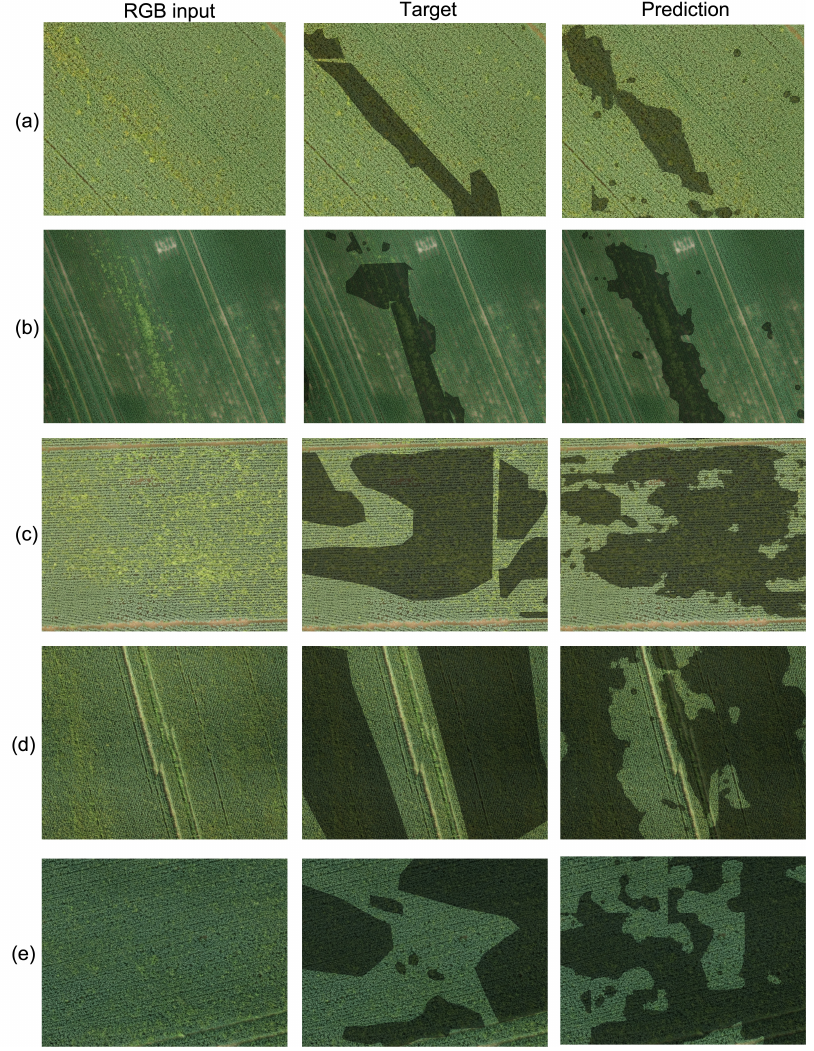
Figure 2. Examples of model predictions for five fields. 1st column: original RGB image (weed represented by yellow and light green plants); 2nd column: target labels overlaid over RGB images; 3rd column: model prediction overlaid over RGB